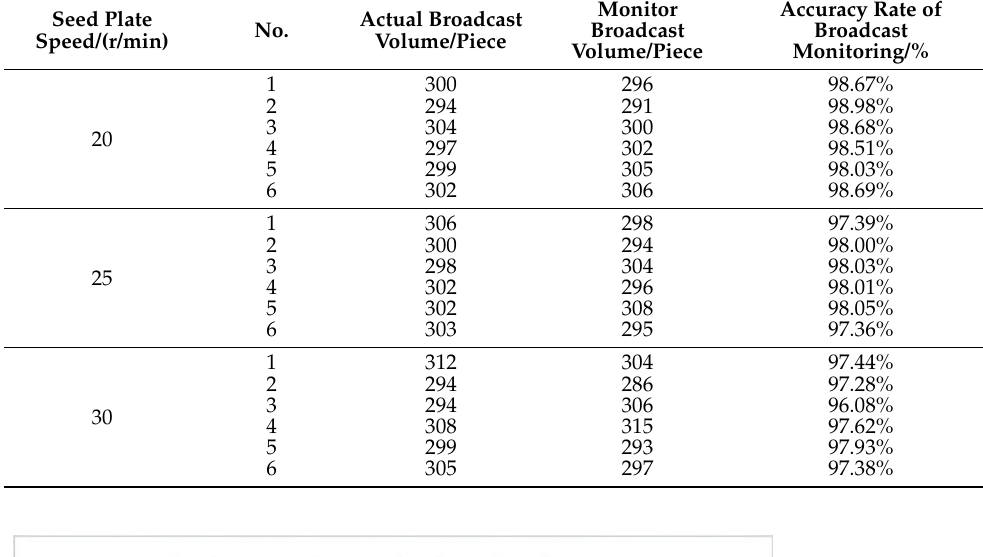
Table 1. Sowing rate monitoring results of the seed meter at different speeds.